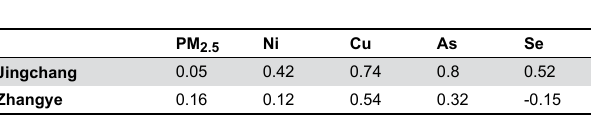
Table 2. Correlations of personal exposure and central site concentrations of PM and key elements in Jingchang and 2.5 Zhangye.